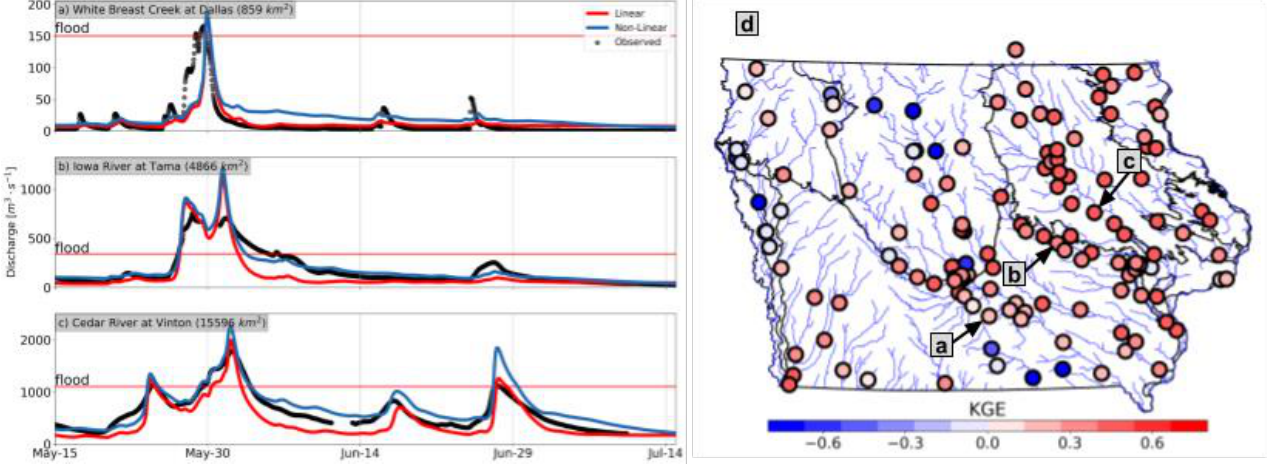
Figure 1. ( a – c ) Observed (black) and simulated streamflows by the linear (red) and the non-linear (blue) setups at three USGS gauged stations. ( d ) Mean annual KGE performance of the HLM linear setup for Iowa between 2002 and 2018.